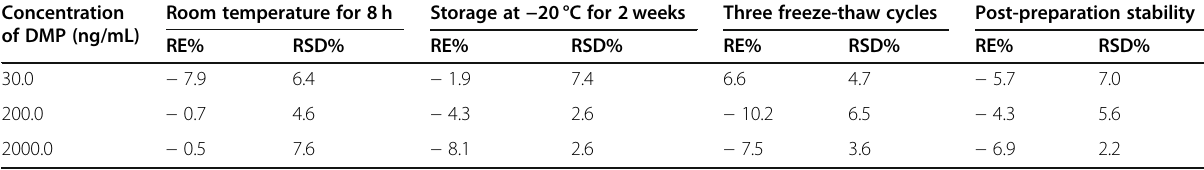
Table 2 Stability results of DMP in rat plasma under different storage conditions ( n = 3) Concentration Room temperature for 8 h Storage at − 20 °C for 2 weeks Three freeze-thaw of DMP (ng/mL)